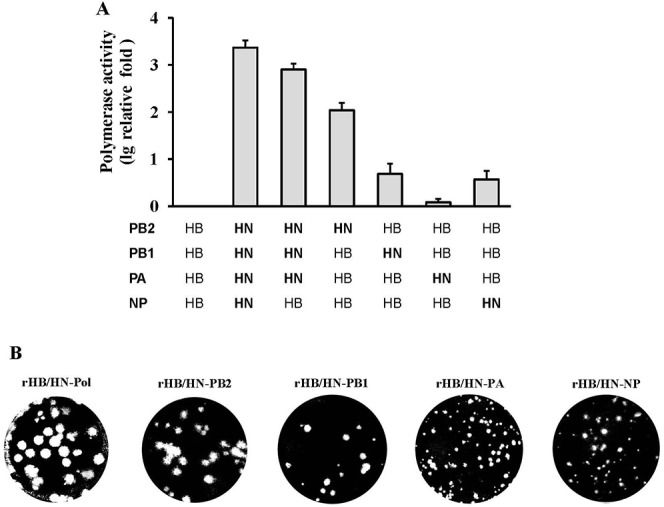

In vitro polymerase activities of vRNPs and plaque formation of recombinant viruses.(A) Polymerase activities of reconstituted HB04 and HN05 vRNP complexes composed of the indicated plasmids. 293T cells were transfected with the pPolI-NS-Luc plasmid and pRL-TK (internal control plasmid) as well as plasmids expressing PB2, PB1, PA and NP derived from either the HB04 or HN05 virus. Cells were incubated at 37°C for 24 h, and Firefly and Renilla luciferase activities were measured in the cell lysates. The data are represented as the means ± SD of the three independent experiments, expressed as log10 relative fold to HB04 RNP activity. (B) Plaque formation after virus titration in MDCK cells.